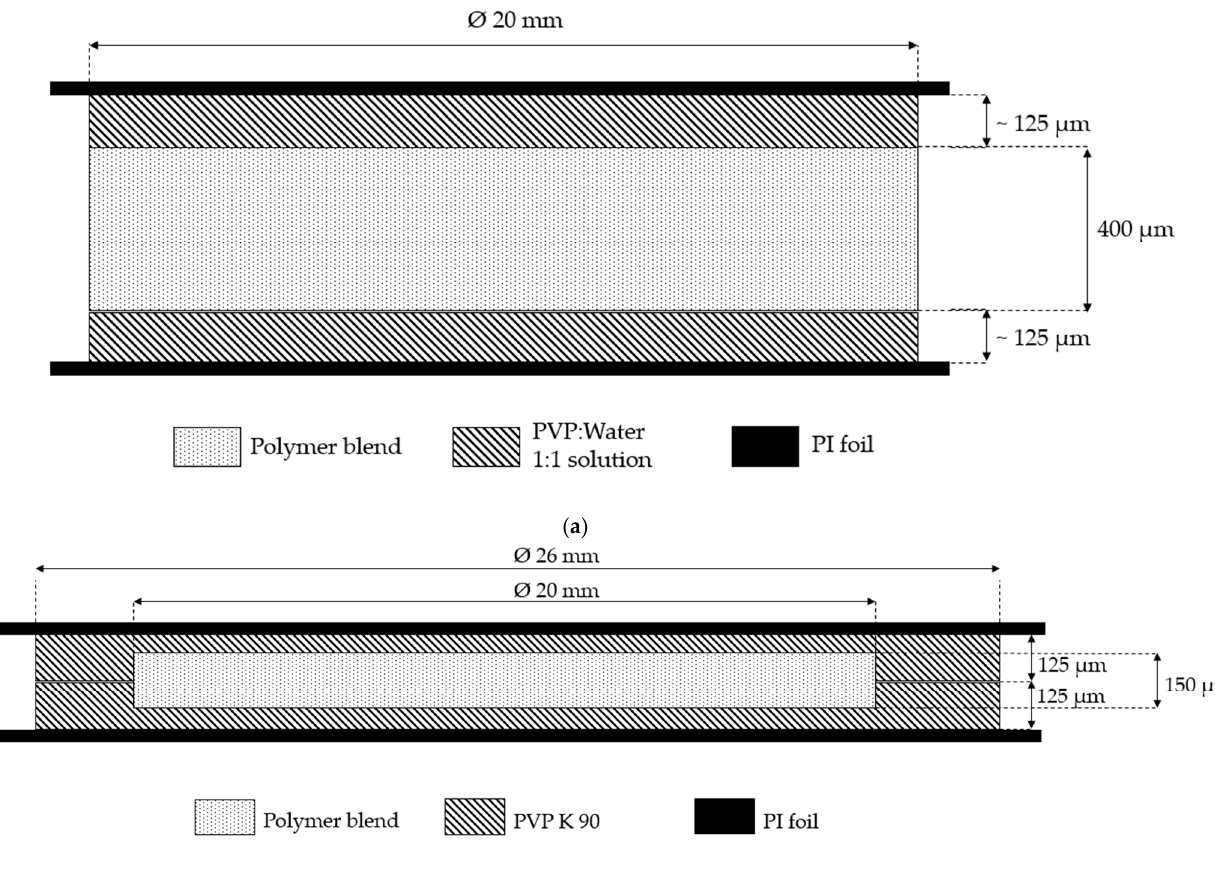
Figure 1. Scheme of a sandwich-type sample: ( a ) Method I; ( b ) Method II.